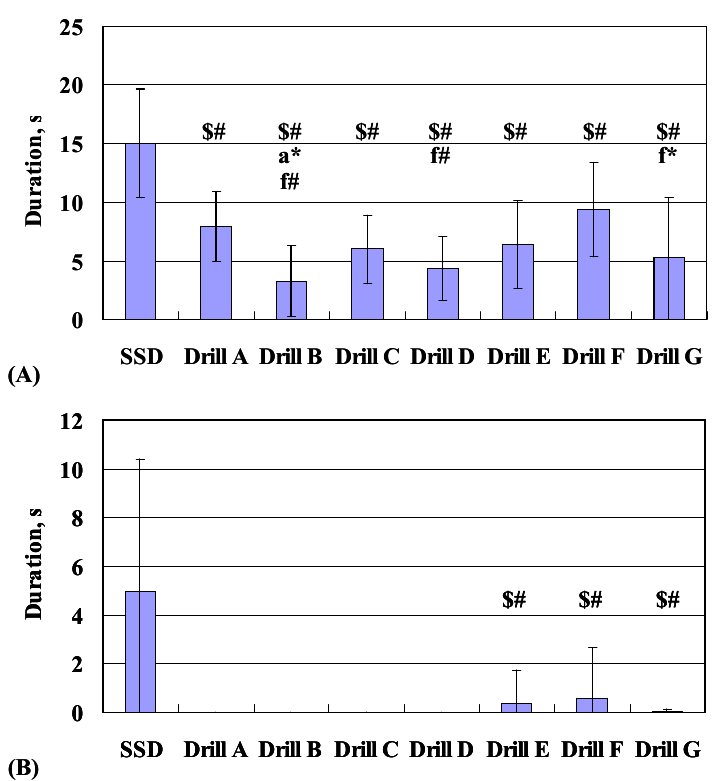
Fig. 7 The period of a temperature increase of at least 13°C, at distances of (A) 0.7 and (B) 1.5 mm from the test hole. $, a, and f are significantly different compared to the SSD and Drills A and F, respectively. * P<0.05, #